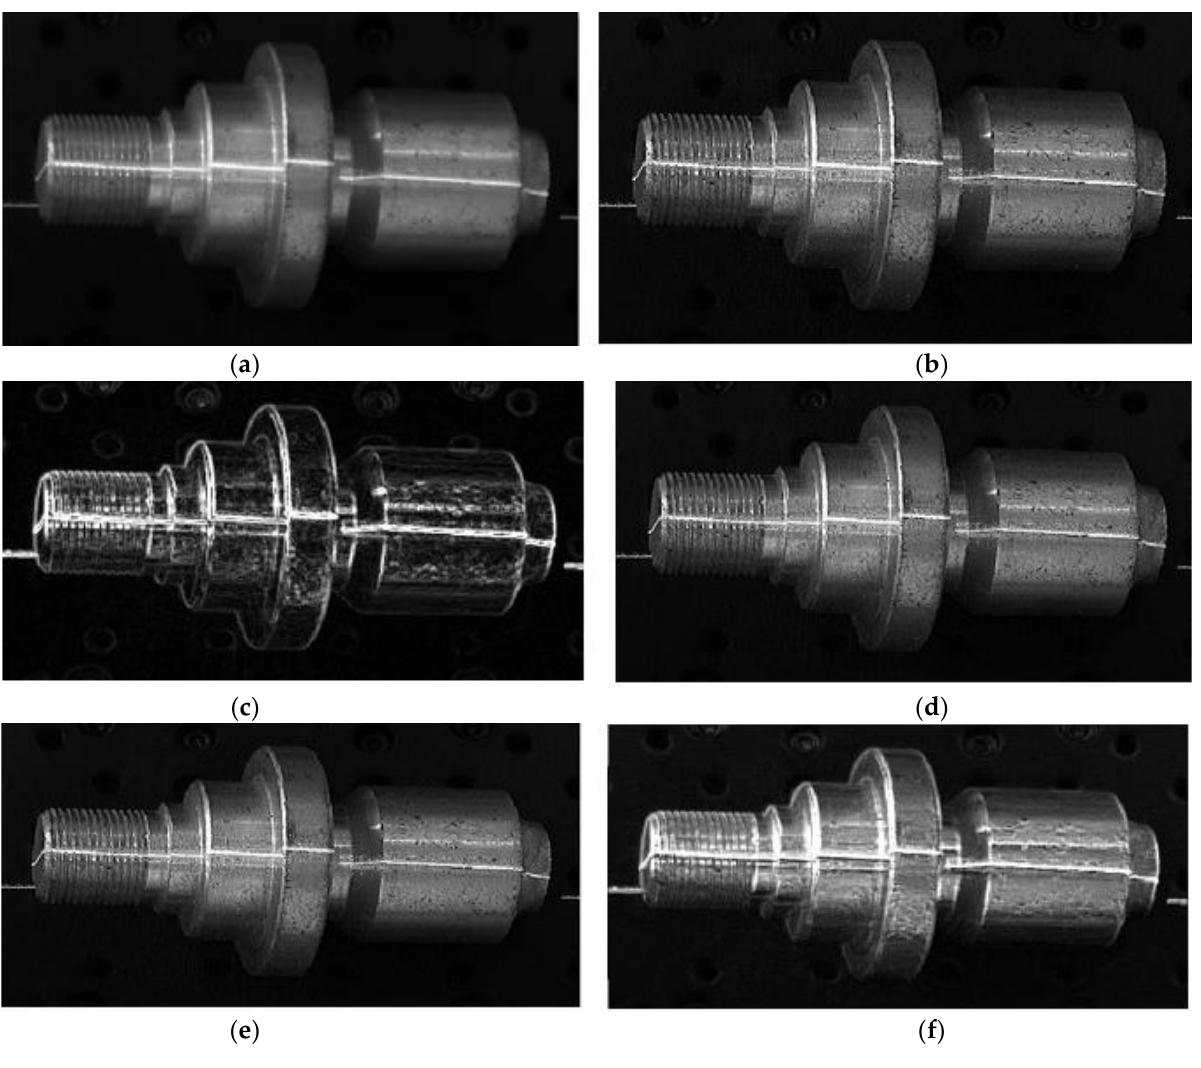
Figure 7. Image enhancement effect of the roller (steel): ( a ) original drawing of the roller (steel); ( b ) Laplacian reinforcement; ( c ) Sobel enhancement; ( d ) v = 0.5 differential enhancement; ( e ) V = 0.7 differential enhancement; ( f ) v = 0.8 differential enhancement.